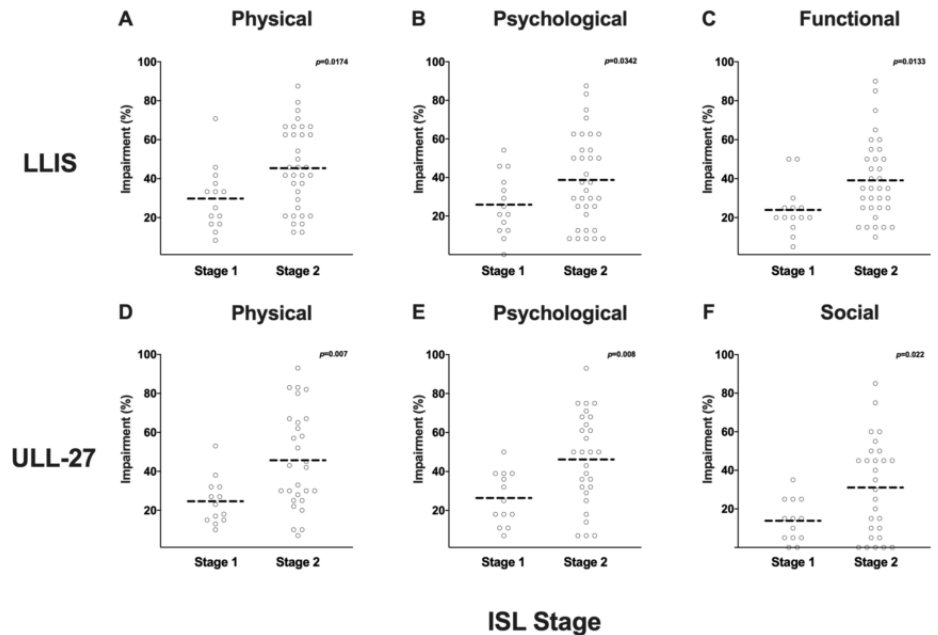
Figure 5. ( A ) Scatter plot of ISL stage vs. LLIS physical domain impairment score (%). ( B ) Scatter plot of ISL stage vs. LLIS psychological domain impairment score (%). ( C ) Scatter plot of ISL stage vs. LLIS functional domain impairment score (%). ( D ) Scatter plot of ISL stage vs. ULL-27 physical domain impairment score (%). ( E ) Scatter plot of ISL stage vs. ULL-27 psychological domain impairment score (%). ( F ) Scatter plot of ISL stage vs. ULL-27 social domain impairment score (%). Cancers 2020 , 12 , x